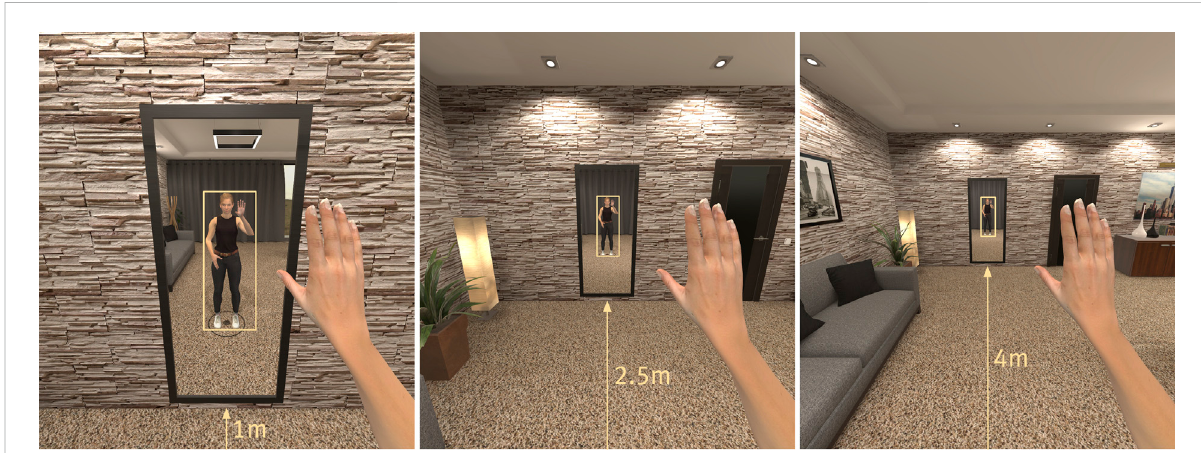
FIGURE 1 Theuser ’ s fi rst-personperspectivemonocularlyrenderedaccordingtotheValveIndexrenderingparametersfortheshort(left),middle(center), and far (right) SOD. The yellow outlined areas within the virtual mirror highlight the decreasing size of the third-person perspective on the avatar in the user ’ s fi eld of view with increasing SOD.